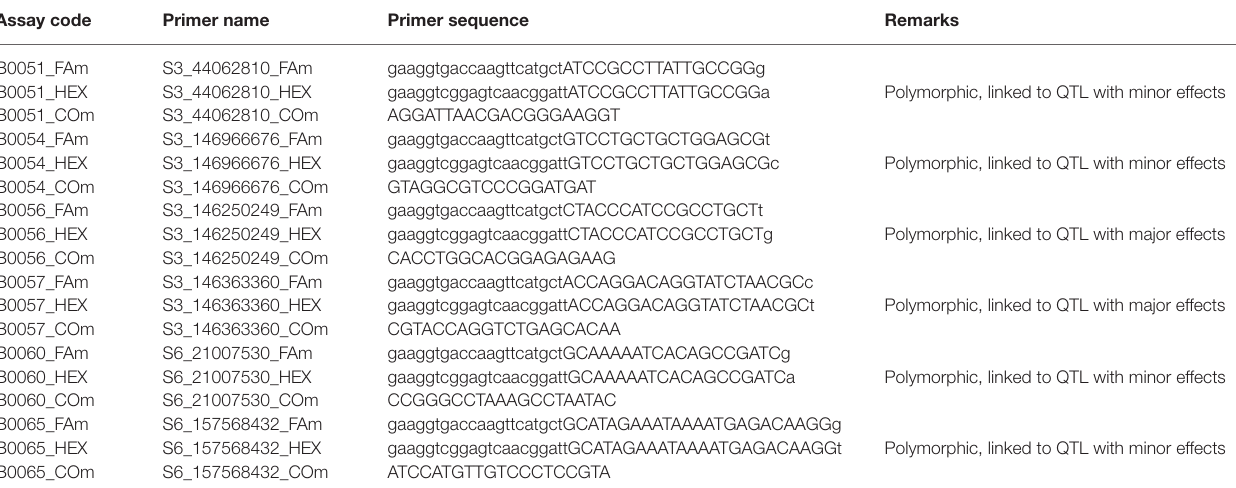
TABLE 4 | List of six polymorphic KAPS primers validated for resistance to MLN using 20 parent lines including a resistant donor parent. Assay